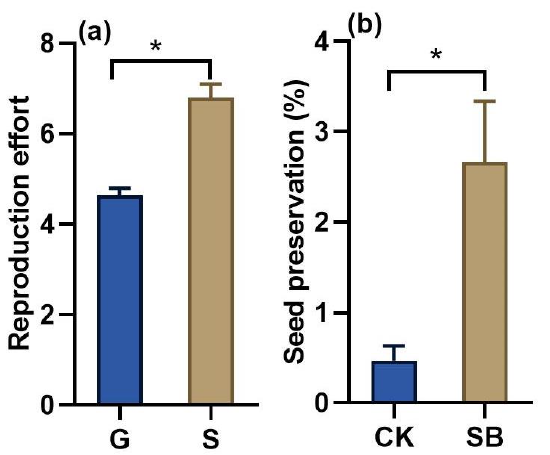
Figure 3. ( a ) Reproduction effort (seed/g biomass) of Caragana stenophylla in grassland and sandy land (mean ± SE). G, grassland; S, sandy land. * indicate significant differences between grassland and sandy land, p < 0.05, t -test. ( b ) Effect of sand burial on seed preservation of Caragana stenophylla (mean ± SE). CK, ground surface; SB, sand burial. * indicate significant differences between sand burial and ground surface, p < 0.05, t -test.